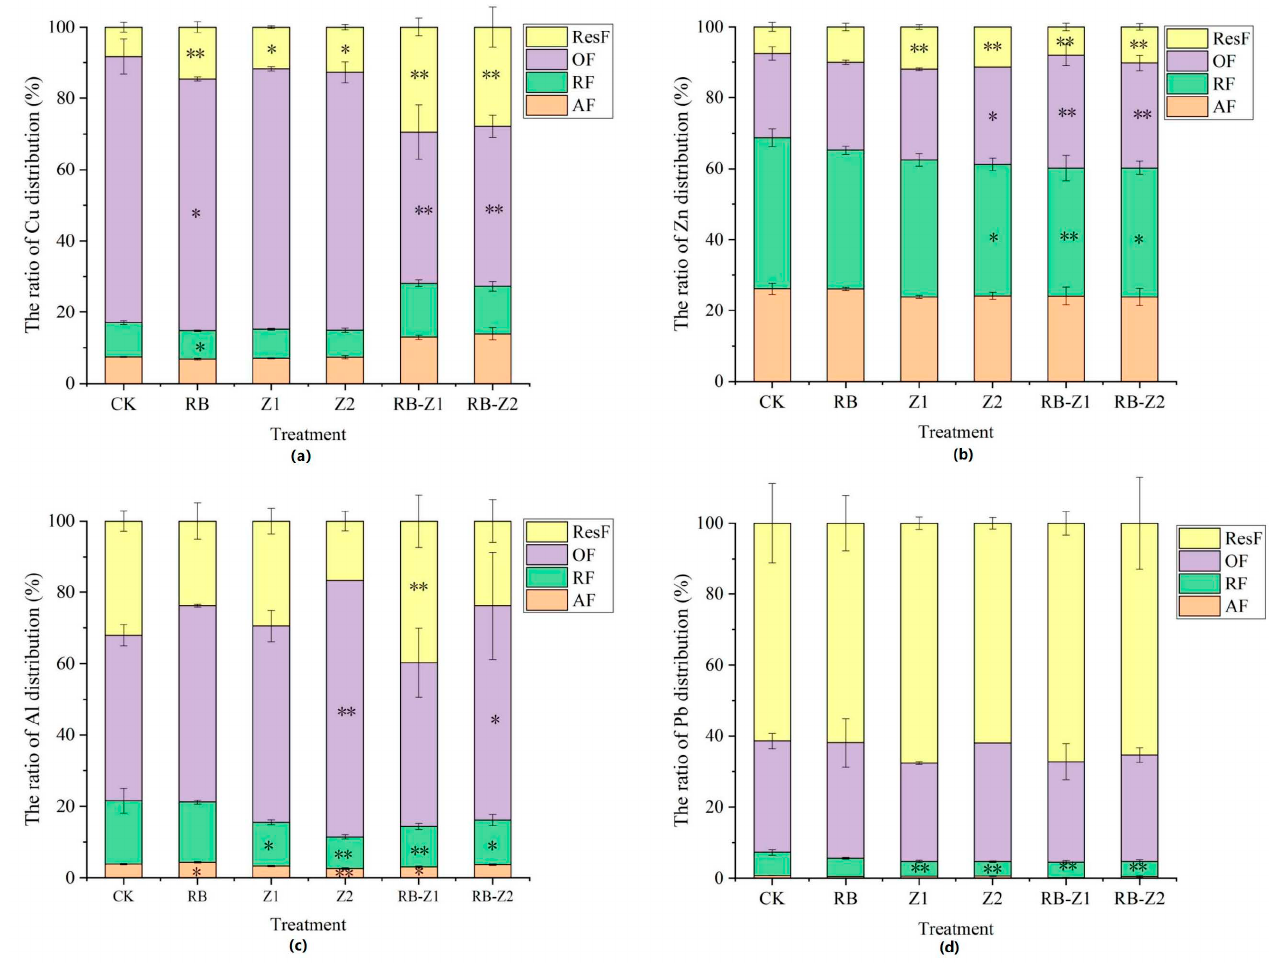
Figure 3. Distribution and transformation of multiple metals in rhizosphere soil under different treatments, ( a ) Cu, ( b ) Zn, ( c ) Al and ( d ) Pb. The data are means ± SD, n = 3. Asterisks (* and **) denote a value significantly greater than the corresponding control value (one asterisk means p < 0.05 and two asterisks indicate p ≤ 0.01).